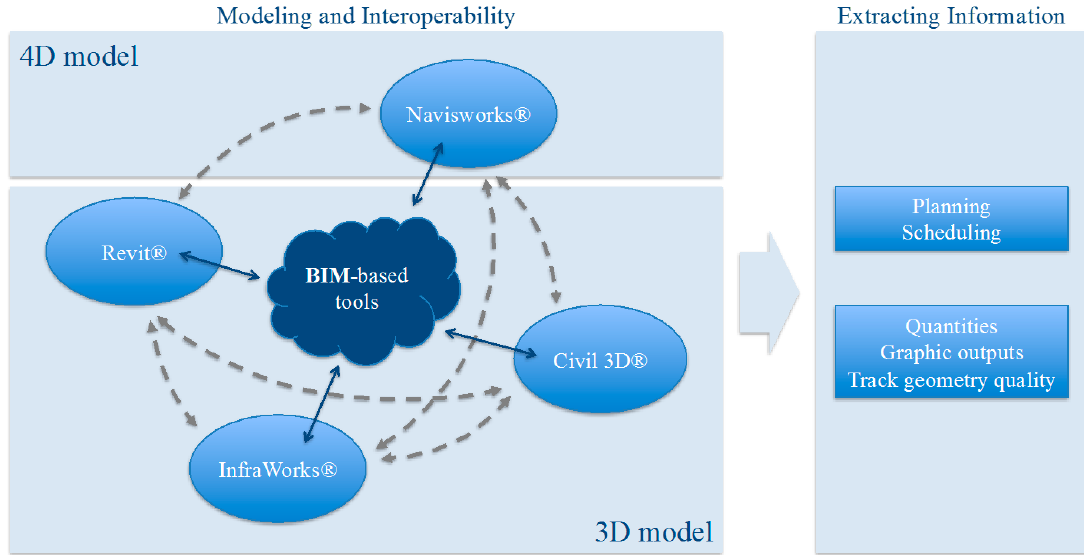
Figure 3. Application of BIM in the case study.